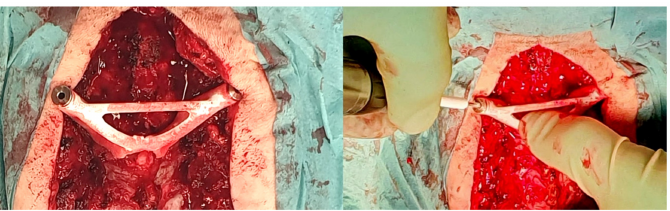
Figure 1. 3DPG positioning and high-speed pilot hole drilling. A drill stop was slid over the drill bit to prevent penetration of the anterior cortex.